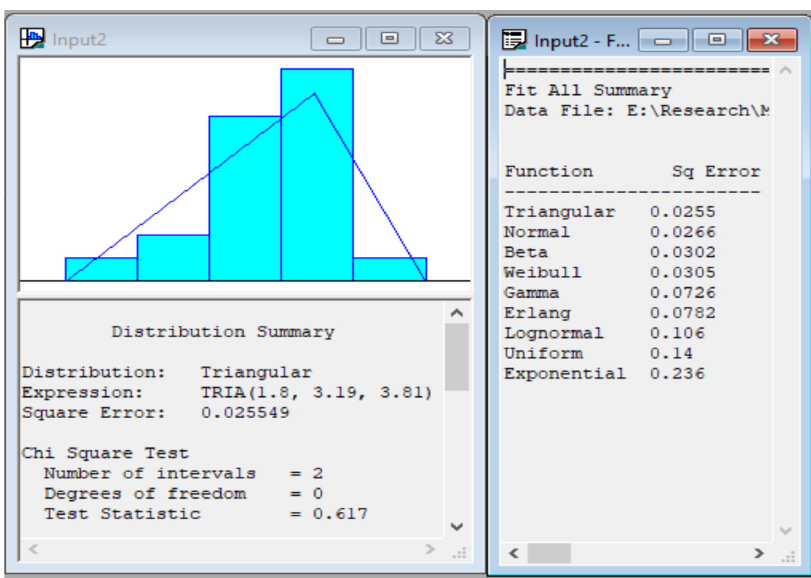
FIG. 2. SERVICE DISTRIBUTION OF PATIENTS BY THE RECEPTIONIST